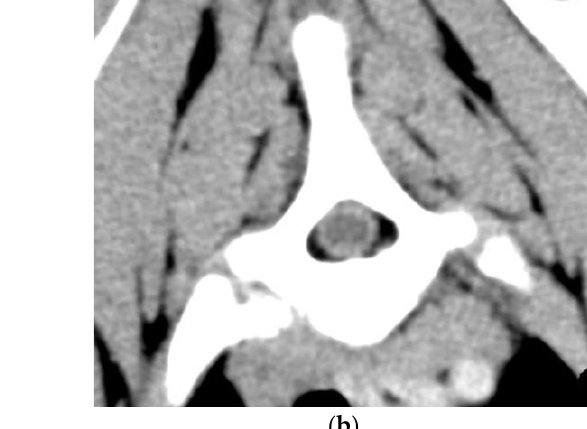
Figure 2. Transverse images at the level of Th2: ( a ) Pre-contrast ( b ) Post-contrast. Reconstructed with soft tissue algorithm, demonstrating an increased meningeal contrast enhancement (WW 150, WL 35).